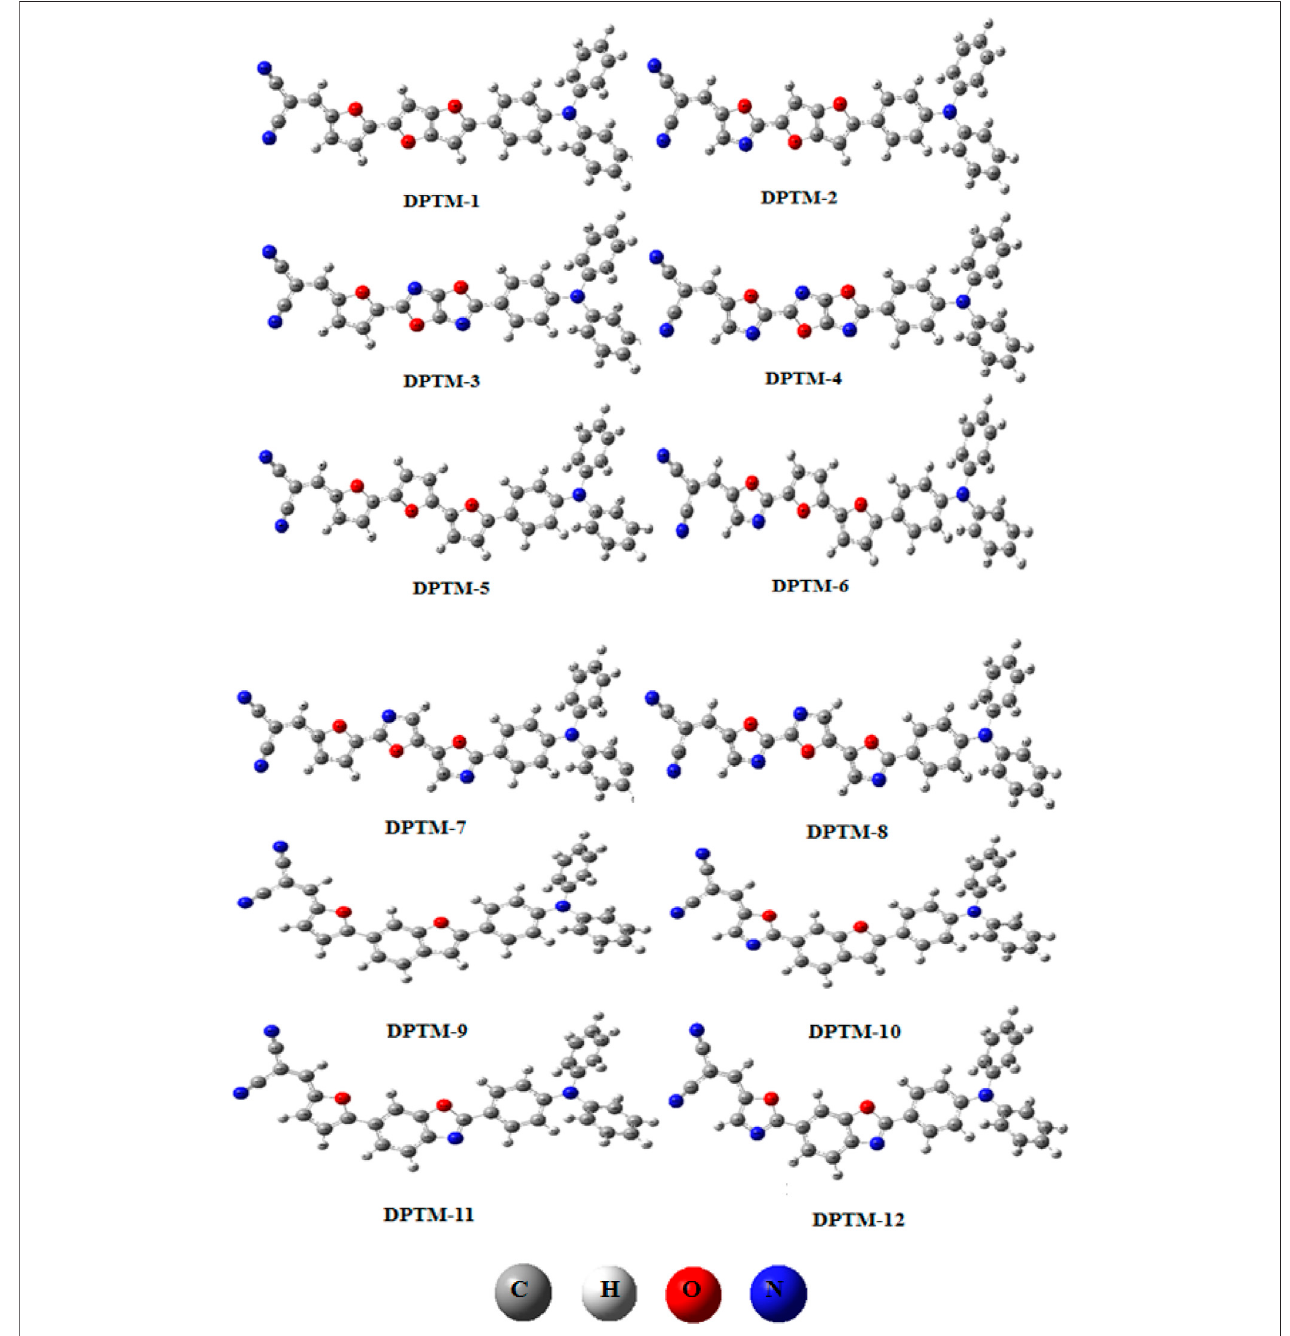
FIGURE 2 | Optimized structures of the investigated compounds ( DPTM-1 to DPTM-12 ).